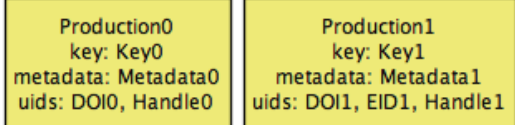
Figure 4. Initial PTCRIS profile.